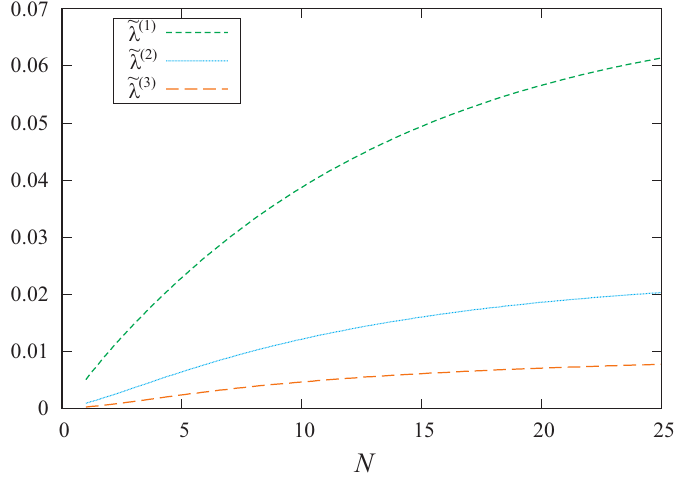
Figure 2. The dependence of N buf fer and N